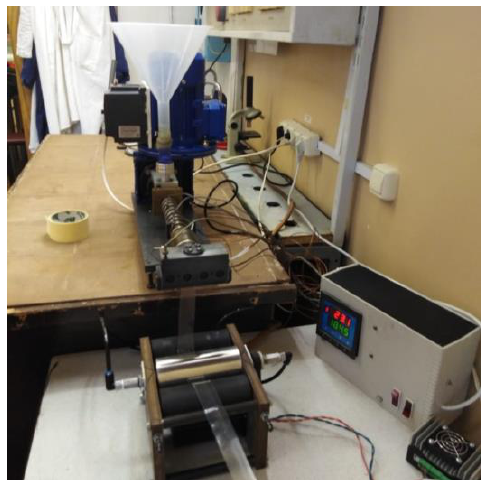
Figure 3. Laboratory extruder for forming flat film.